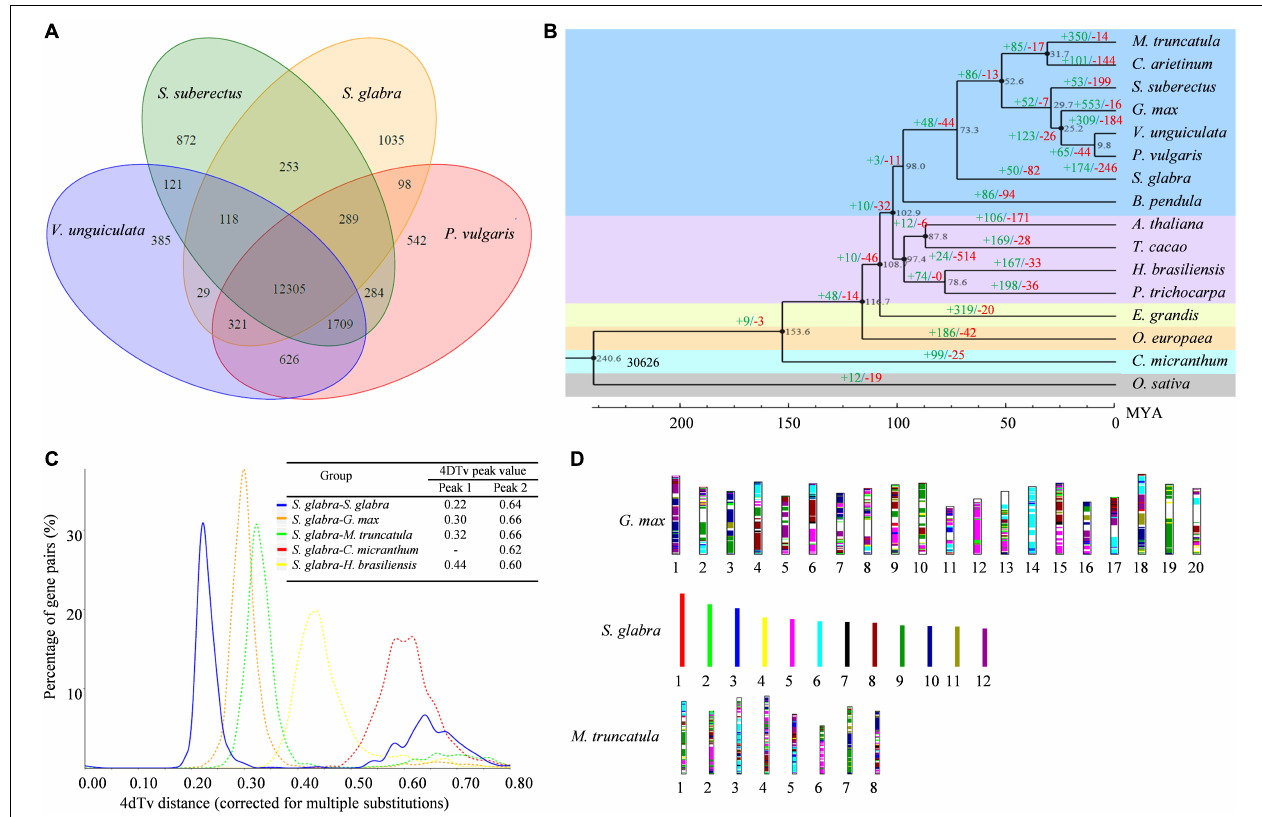
FIGURE 2 | Evolution of S. glabra genome. (A) A Venn diagram of common and unique gene families among four Leguminosae species based on the gene family cluster analysis. (B) Phylogenetic tree of 16 species based on single-copy gene families. The black number at each branch point denotes the estimated divergence time. The value above each branch denotes the number of gene family expansion (in green)/contraction (in red) at each round of genome duplication after divergence from the common ancestor. Bootstrap value for each node is 100. (C) Density distribution of 4dTv values. The peak value is shown in the inset. The blue line represents the 4dTv of paralogous genes in S. glabra . The orange, green, red and yellow dotted lines represent 4dTv of orthologous gene pairs between S. glabra and G. max , S. glabra and M. truncatula , S. glabra and C. micranthum , S. glabra, and H. brasiliensis , respectively. (D) Schematic representation of syntenic genes among S. glabra , G. max, and M. truncatula . Syntenic blocks were determined by using all 20 chromosomes of G. max, 12 chromosomes of S. glabra and 8 chromosomes of M. truncatula. The same color indicates matched gene